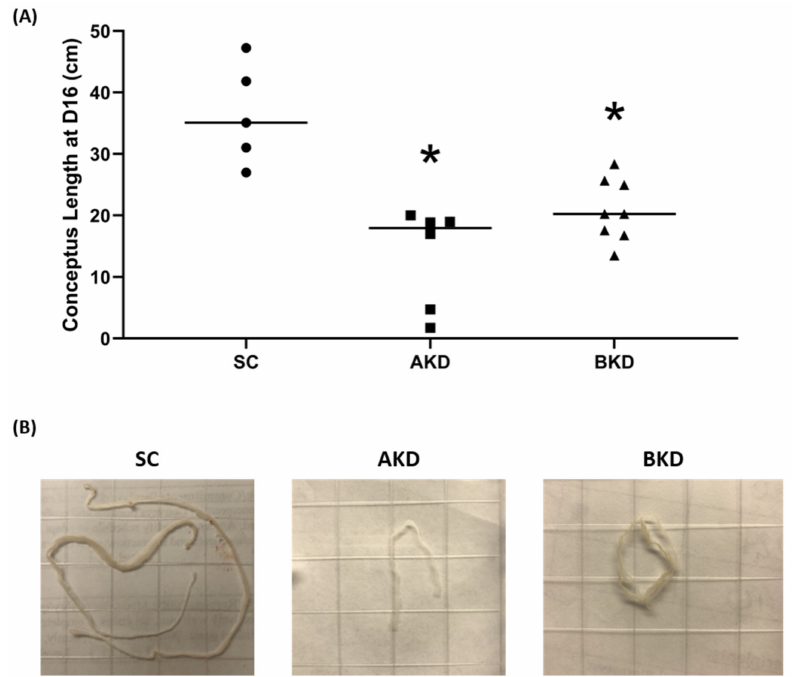
Figure 2. ( A ) Conceptus length at day 16 after LIN28A knockdown (AKD, n = 6) and LIN28B knockdown (BKD, n = 8) compared to scramble control (SC, n = 5). ( B ) Representative images of day 16 sheep conceptuses for AKD, BKD, and SC day 16 TE; * p < 0.05 vs.